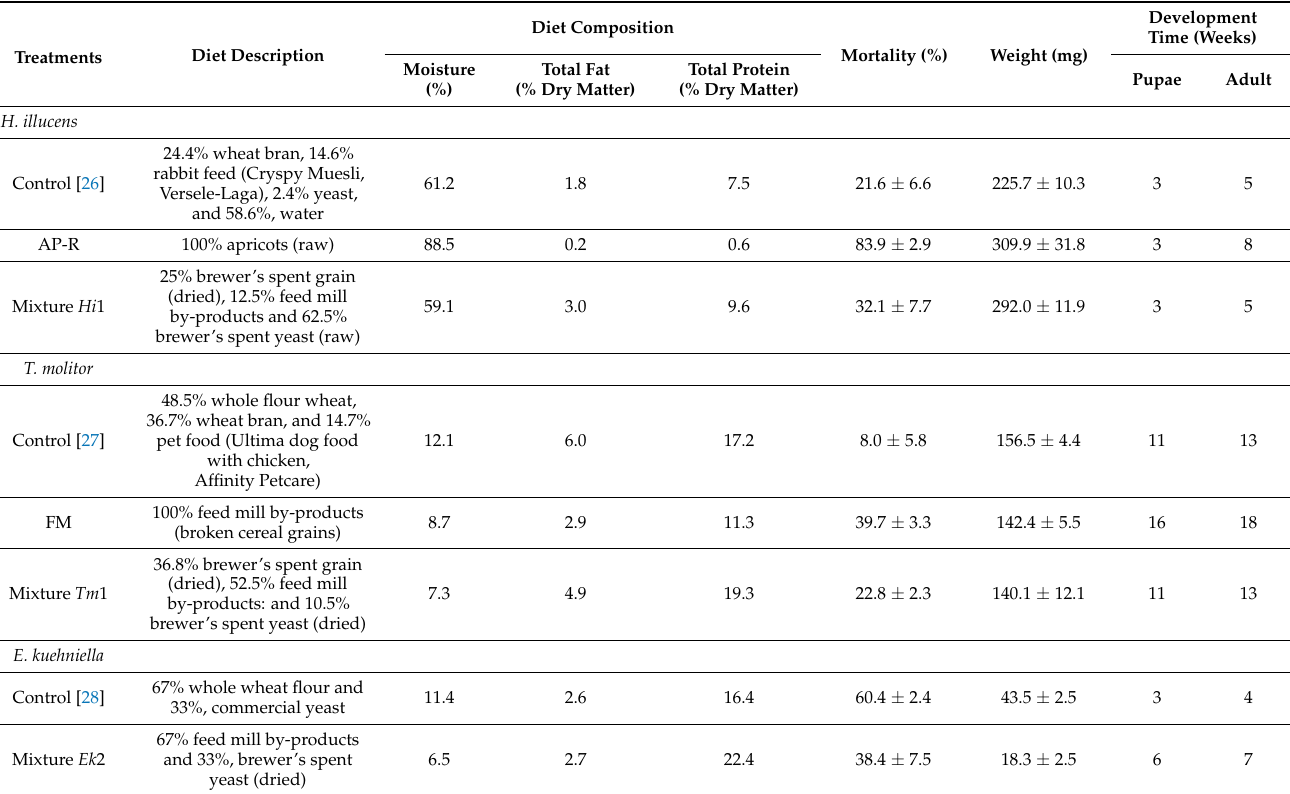
Table 1. Description of the diets included in this study (main components as described in Riudavets et al. [25]).